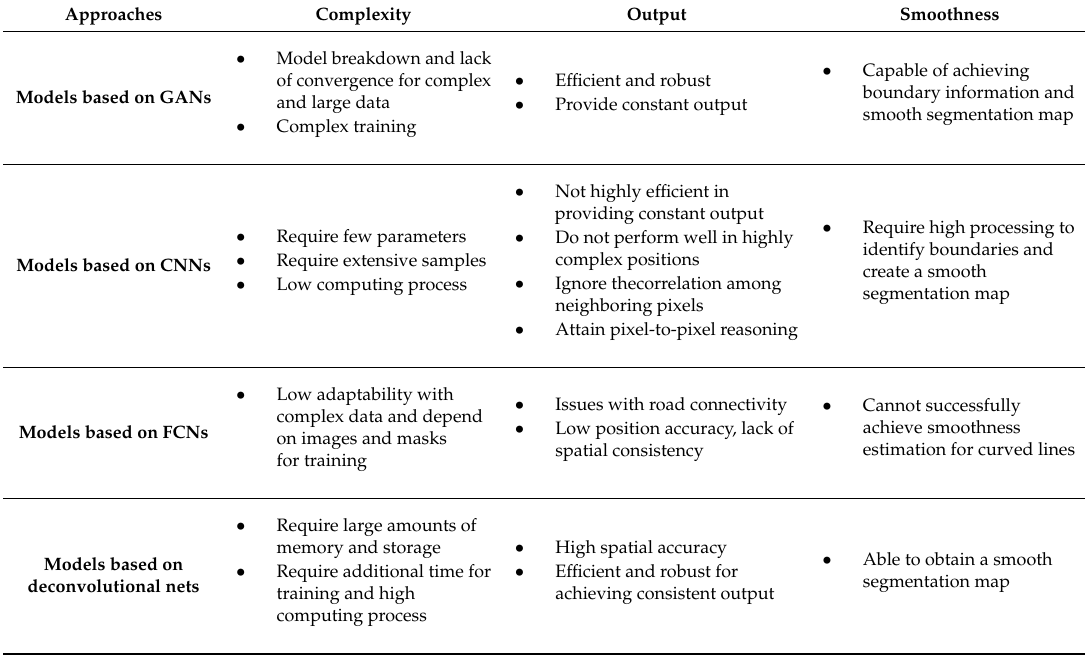
Table 1. Strengths and limitations of various deep learning methods for road